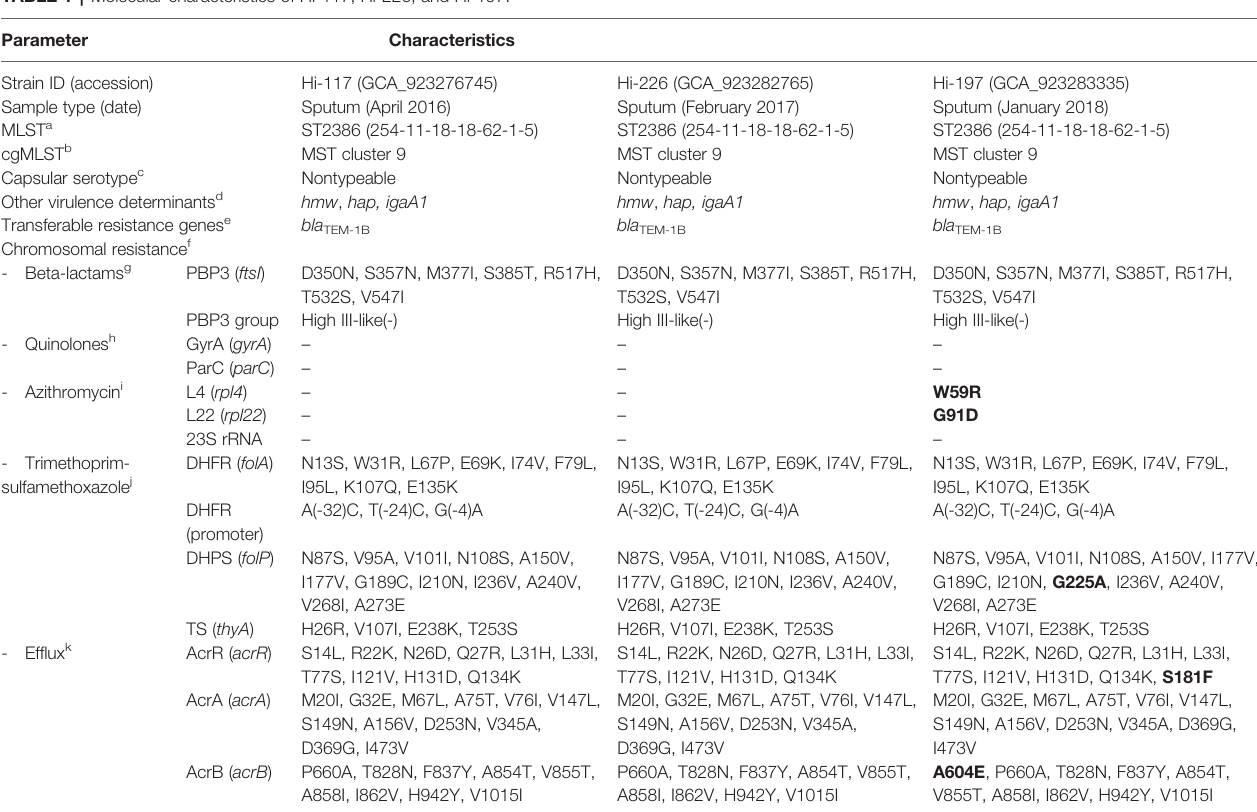
Table 1 summarizes the molecular basis of resistance to the different antibiotic groups, and depicts virulence determinants that might in fl uence persistence, despite antibiotic therapy. Hi-